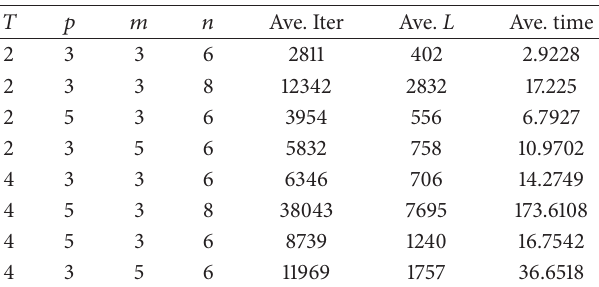
Table 5: Numerical results for random